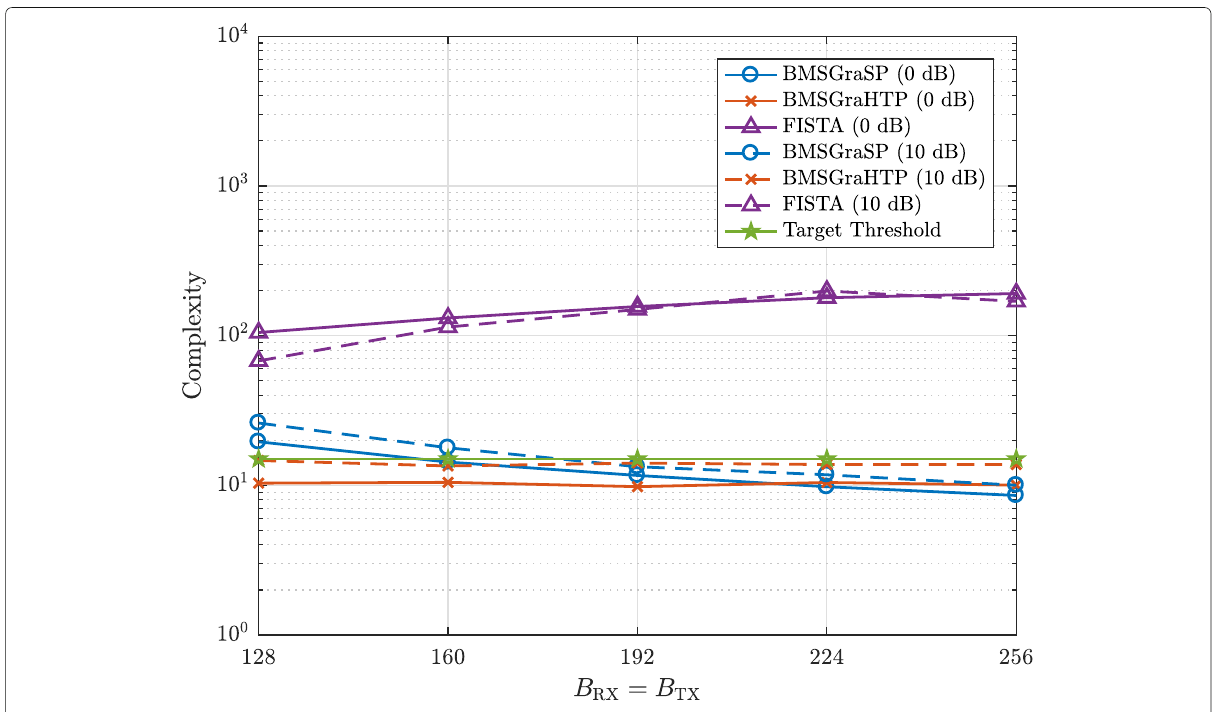
Fig. 8 Normalized complexity vs. B RX = B TX where M = N = 64, T = 80, and L = 4 at SNR = 0 dB and SNR = 10